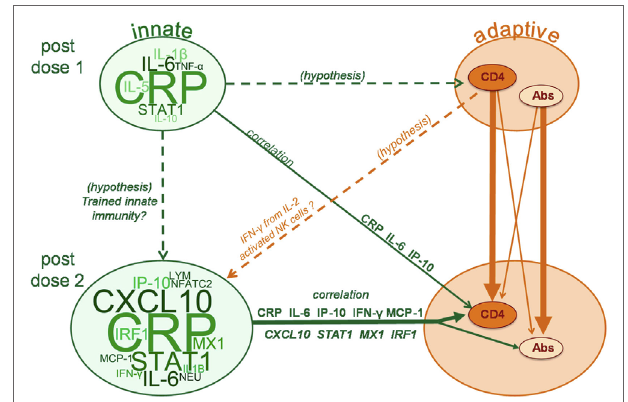
FiGUrE 7 | Model schematic of the interplay between innate and adaptive responses. Word clouds represent changes in levels of serum proteins, hematology parameters or mRNA levels, with cloud and font sizes proportional to the response levels presented for these variables in Figure S1. Solid arrows indicate significant associations observed in the multi-parametric models of adaptive responses to vaccination [i.e., responses of HBs-specific CD4 + T cells [CD4] or antibodies (Abs)], with line thickness proportional to the strength of the associations. Analytes presented on the solid arrows reflect those for which the strongest separation and highest loading was observed on the principal component found to be relevant for the association with adaptive responses. Dashed arrows indicate hypothetical associations that are discussed in the manuscript but not evaluated by the multi-parametric analyses. LYM, lymphocytes; NEU,